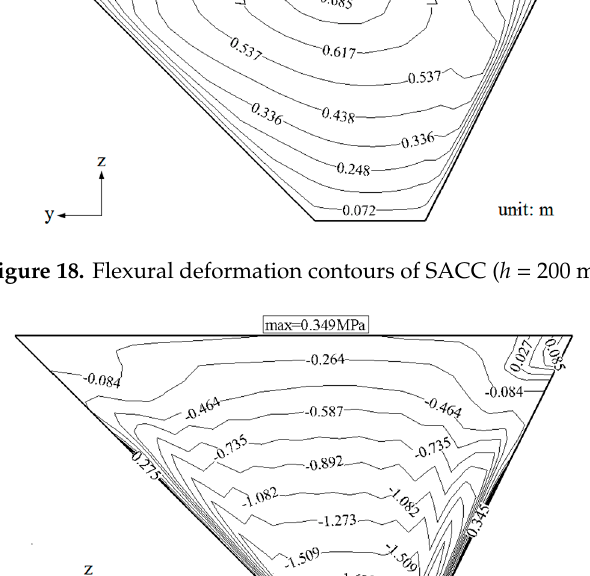
Figure 21. Relationship between tensile stress maximum of SACC and dam height.